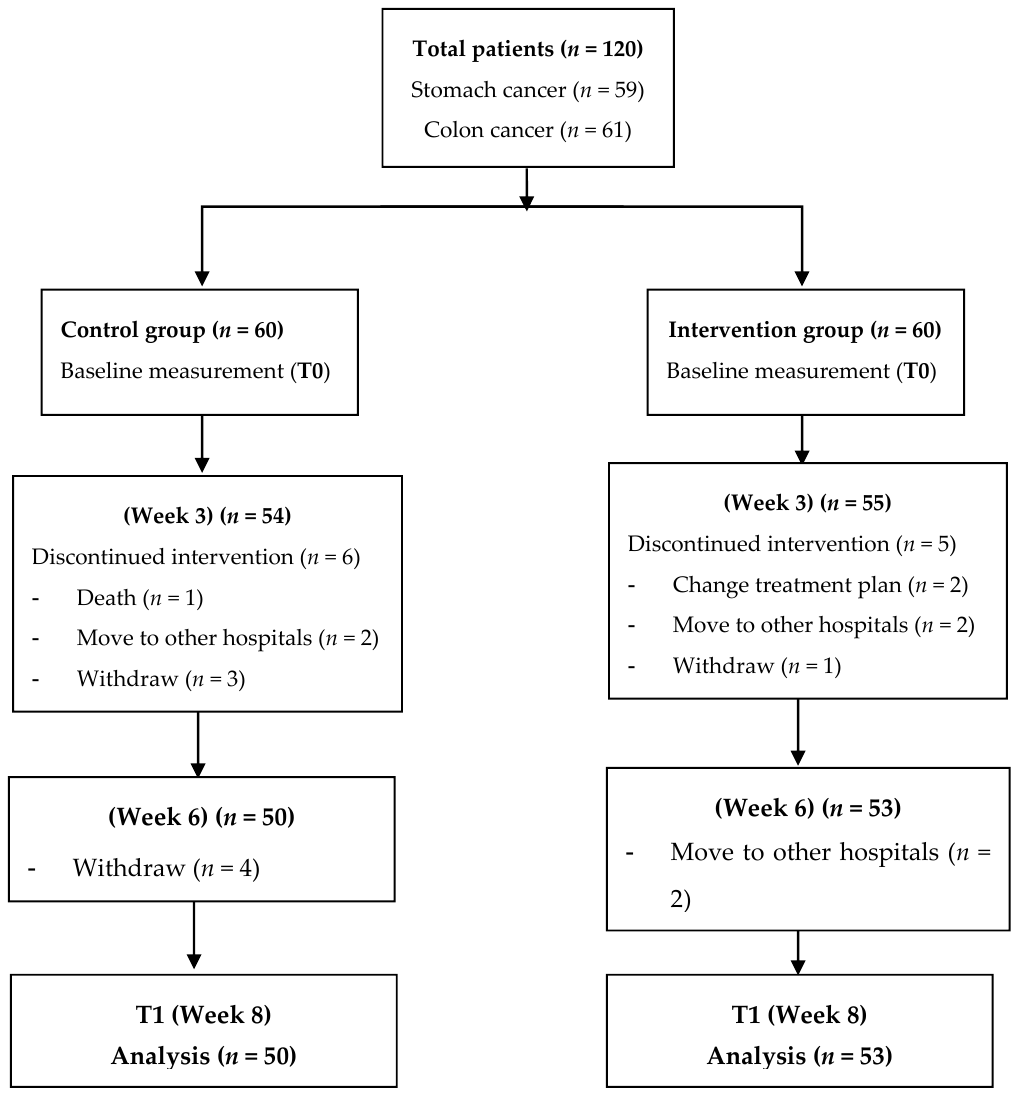
Figure 1. Flow diagram of study design.